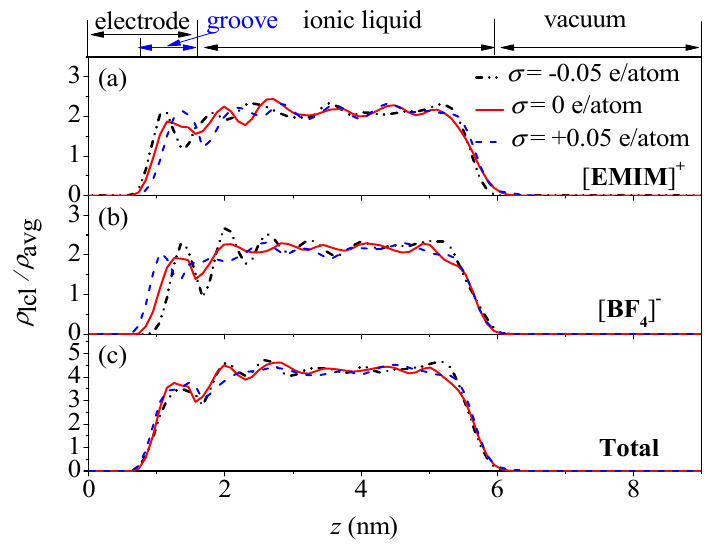
Figure 5. Concentration profiles of [EMIM] + cations and [BF 4 ] − anions near charged/uncharged rough electrodes. ( a ) σ = 0 e/atom, ( b ) σ = +0.05 e/atom, ( c ) σ = − 0.05 e/atom.